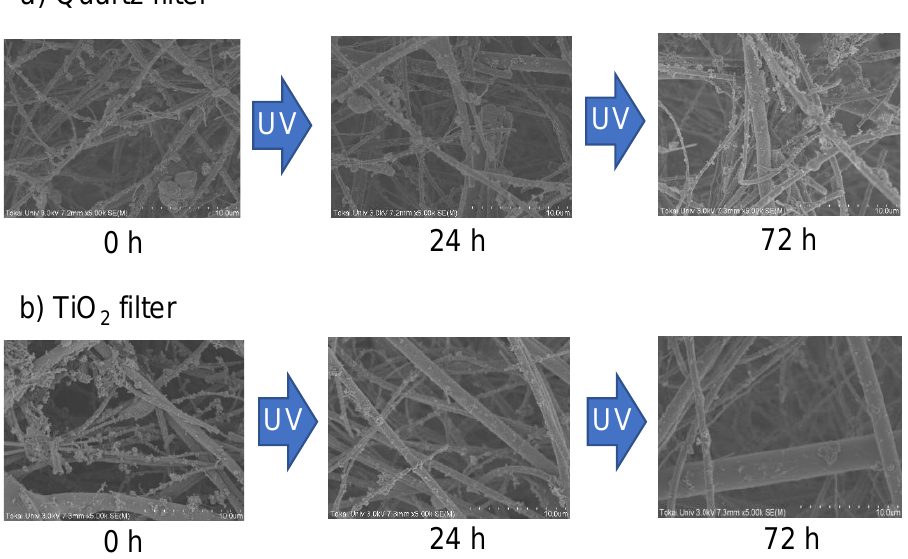
Figure 3. Scanning electron microscope (SEM) images of PM 2.5 particles collected on ( a ) quartz filter and ( b ) TiO 2 filter before and after ultraviolet (UV) irradiation (365 nm, 1.1 mW/cm 2 ) . 2.2. Photocatalytic Degradation of PAHs in PM 2.5